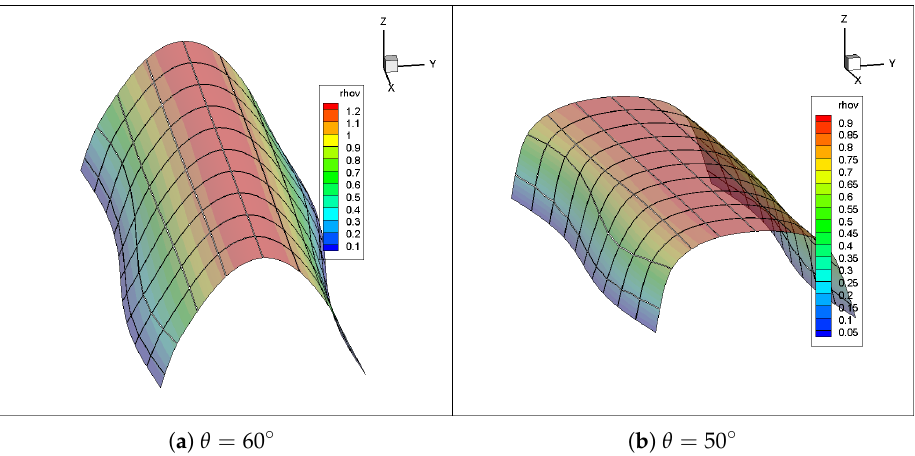
Figure 9. Wavy-walled channel flow at Re = 1150: 3D view of the average spanwise veloc- ity/momentum at two different sweep angles. At θ = 60 ◦ , ρ v velocity shows a laminar-shaped profile, resembling a typical parabolic Poiseuille flow. At θ = 50 ◦ , it is a typical flattened turbulent